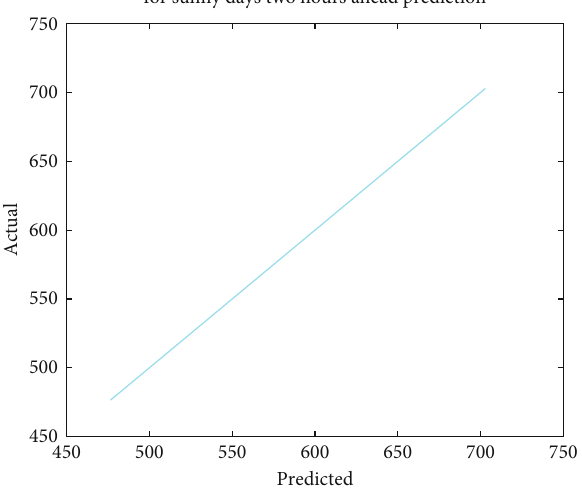
Figure 9: Relationship between actual vs. predicted solar irradiance for sunny day two-hour-ahead prediction.